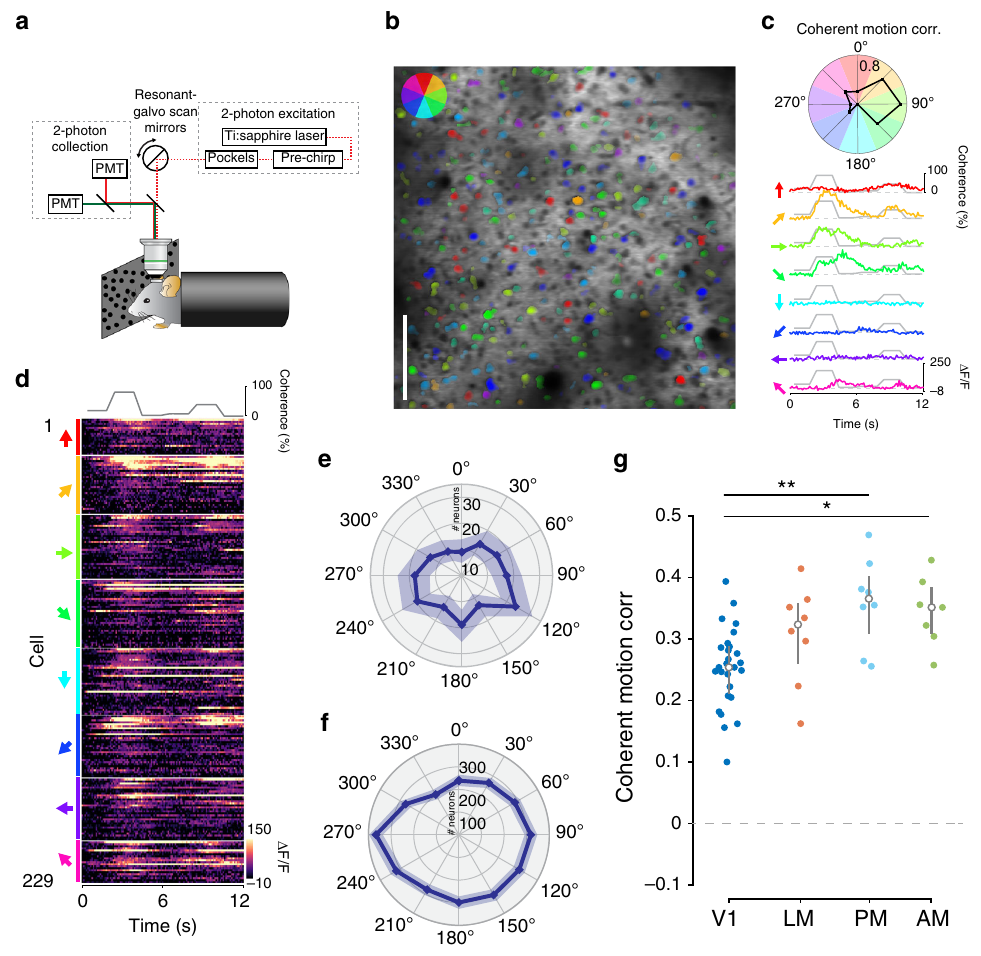
Fig. 6 Coherent motion responses of single cells. a Schematic of the two-photon microscopy experimental setup. b Example two-photon imaging fi eld from V1. Each neuron is color-coded by its preferred direction; the opacity of the color corresponds to its mean activity level. Scale bar is 100 µ m. c Top: polar plot of coherent motion correlation for each motion direction. Bottom: responses of a single example neuron to each of the eight motion directions, highlighting the direction selectivity of an individual neuron. The coherence trace for this session is overlaid on each neural response. d Responses of each cell in the example session, grouped by preferred direction (left, arrows) and ordered by decreasing coherent motion correlation. e Polar plot of averaged directional tuning to coherent motion across all cells in the example session. f Histogram of 30° binned preferred direction of all neurons across all sessions. Note the signi fi cant non-uniformity across all sessions ( n = 3461 cells from 13 mice, p = 1.73 × 10 − 6 , Hodges – Ajne test for non-uniformity). g Mean coherent motion correlation across HVAs. Each point represents the mean coherent motion correlation of all the cells in that session. Although all areas exhibit signi fi cant coherent motion correlations (V1: p = 1.6 × 10 − 17 ; LM: p = 1.3 × 10 − 5 ; PM: p = 3.6 × 10 − 6 ; AM: p = 2.2 × 10 − 6 ), areas AM and PM have signi fi cantly higher coherent motion correlations than area V1 (PM: p = 1.3 × 10 − 2 ; AM: p = 1.7 × 10 − 3 ; two-tailed unpaired two-sample t test). * p < 0.05; ** p < 0.01, two-sample t